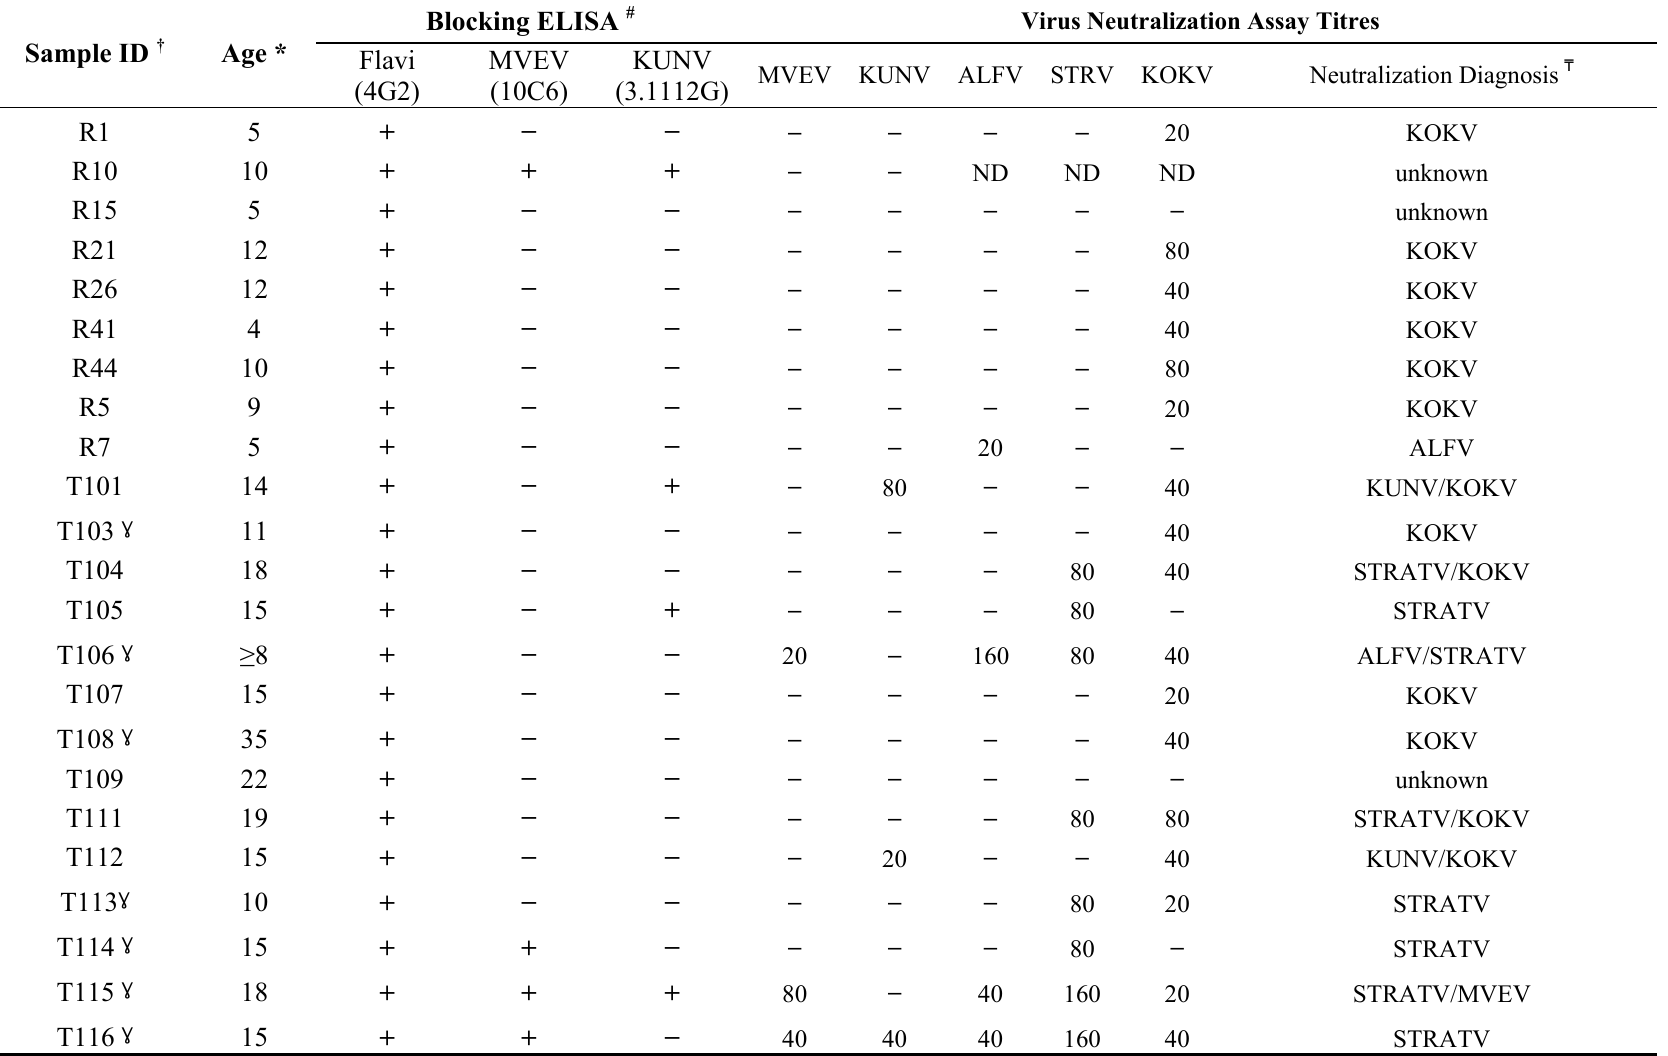
Table 2. Serological analysis of sera that were positive in the Flavi-blocking ELISA †